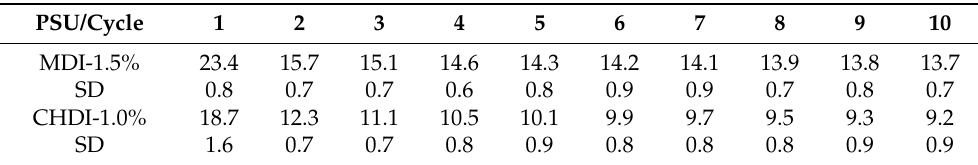
Table A4. Tensile hysteresis at 100% strain of PDMS-based polyurea copolymers synthesized from 4,4 (cid:48) -methylenebis(phenyl isocyanate) (MDI) and trans -1,4-cyclohexane diisocyanate (CHDI) with urea HSs of approximately 1.5% and 1.0%. Values are given as an average of three repeated measurements. SD: standard deviation.